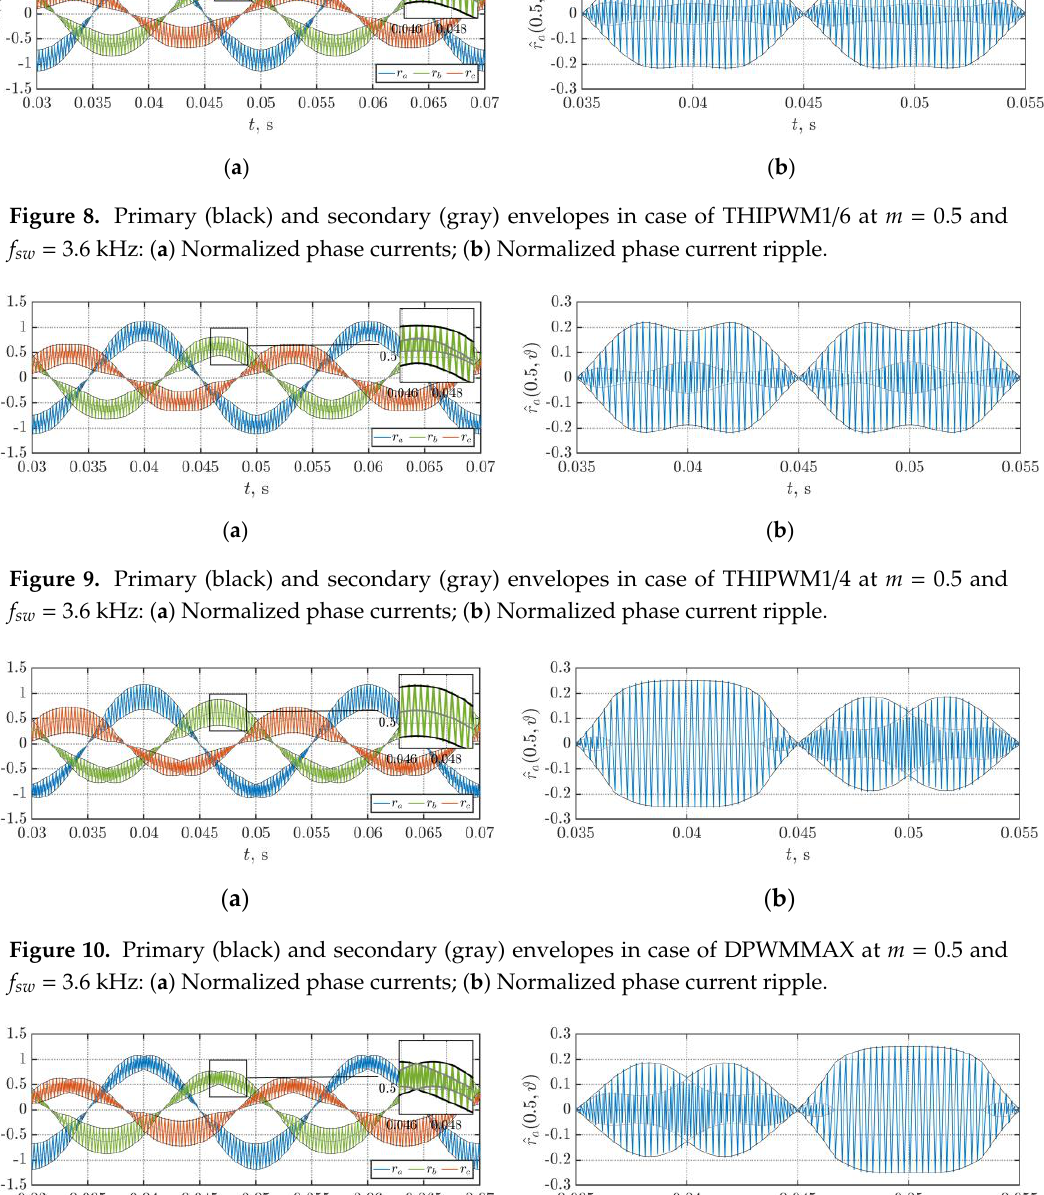
3.6 kHz: ( a ) Normalized phase currents; ( b ) Normalized phase current ripple.